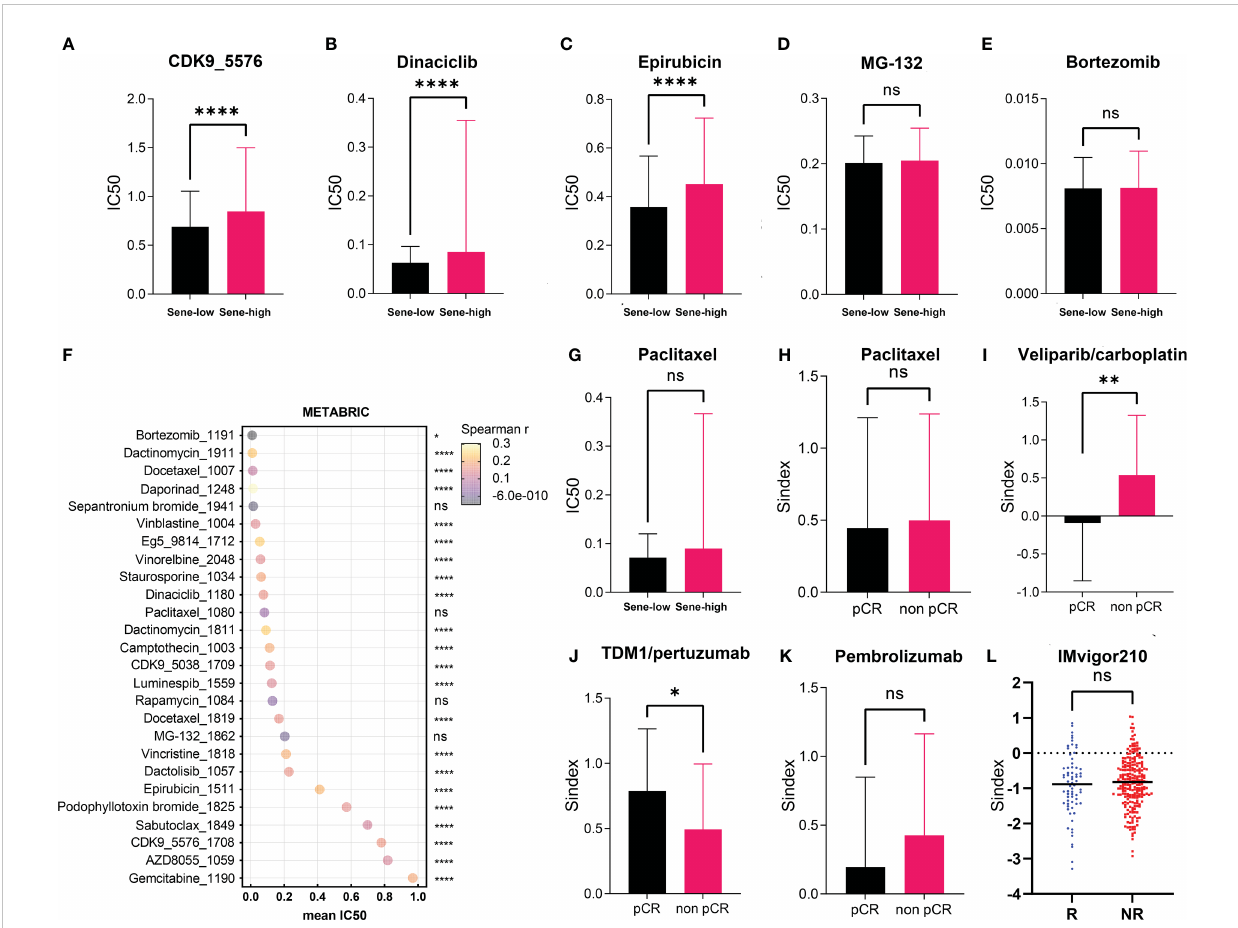
FIGURE 8 Exploration of Sindex for therapeutic response prediction. (A – G) . oncoPredict prediction of IC50 for different chemotherapeutic drugs in patients with BRCA from the TCGA dataset. (A – F) Comparison of predicted IC50 for (A) CDK9, (B) Dinaciclib, (C) Epirubicin, (D) MG-132, (E) Bortezomib, (F) Paclitaxel between sene-high and sene-low. (G) visualization of each drugs ’ predicted IC50 and correlation with Sindex. (H – K) comparisons of Sindex between pCR and non-pCR patients in the ISPY-2 trial to (H) Paclitaxel, (I) Veliparib/carboplatin, (J) TDM1/pertuzumab and (K) Pembrolizumab. (L) comparison of Sindex between R and NR patients in the IMVigor210 trial to atezolizumab * p < 0.05, **p < 0.01, ****p < 0.0001. ns, no signi fi